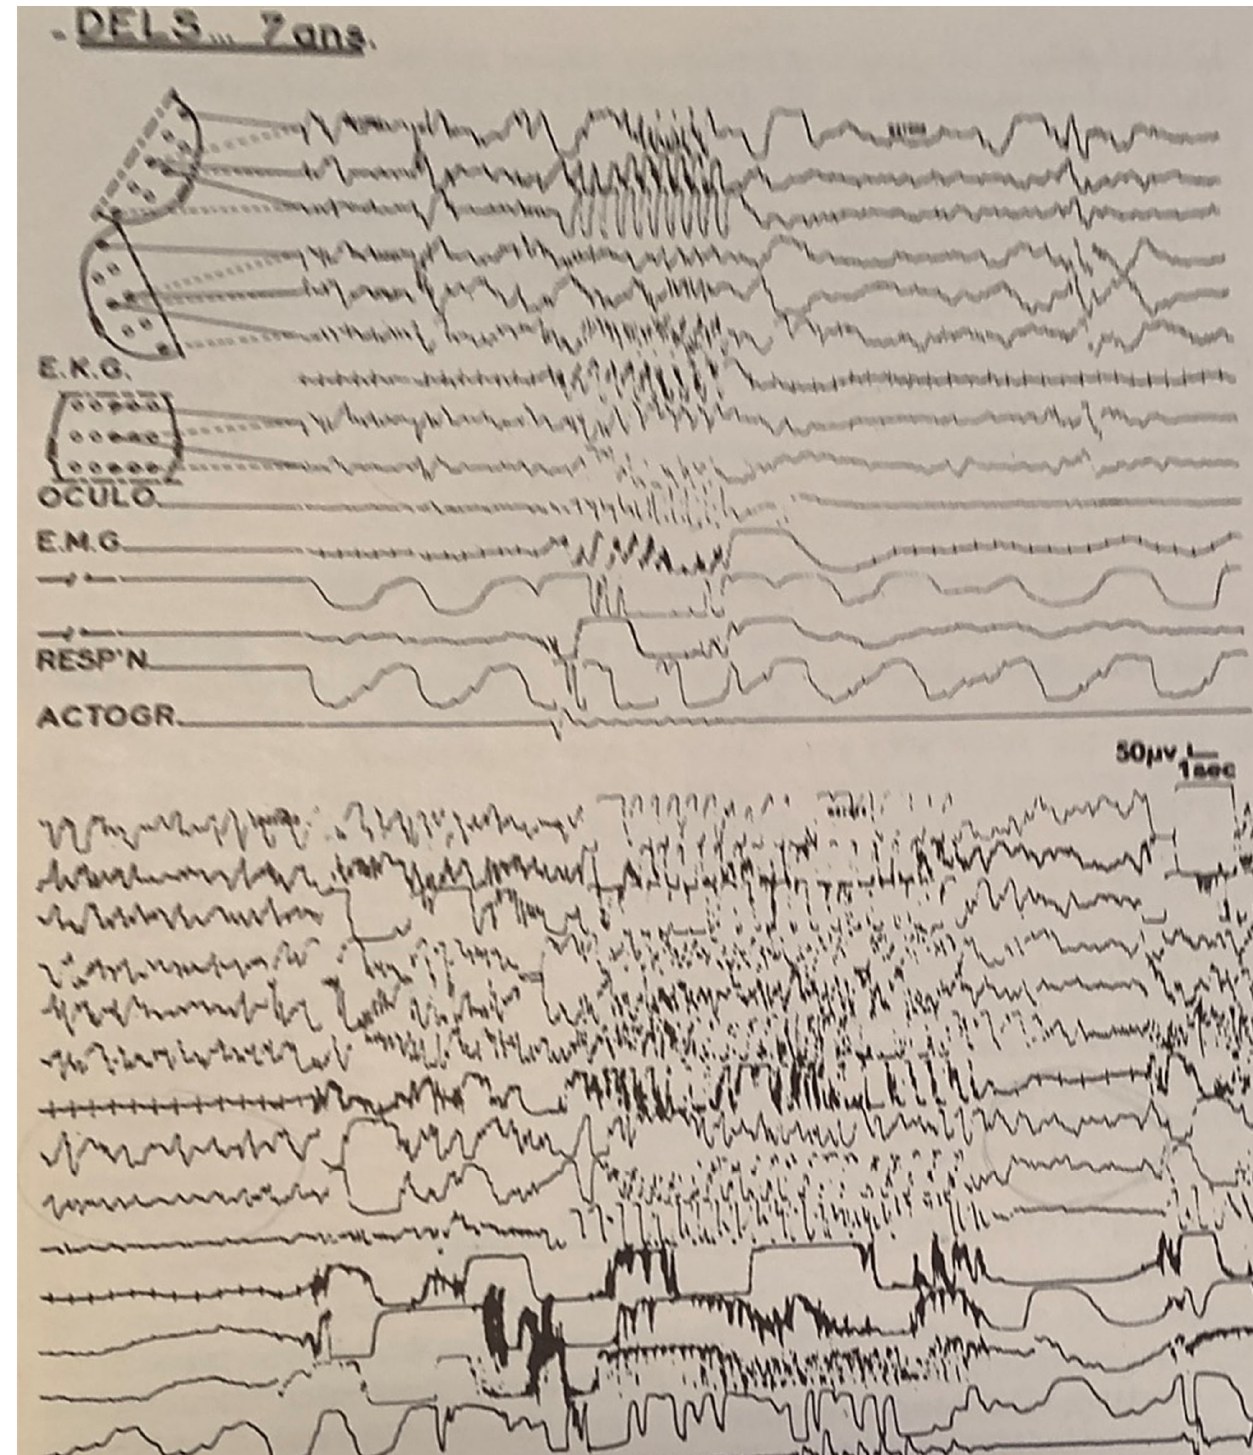
Figure 22. Extreme jactatio capitis nocturna in a 7 ‐ year old child with total body movements. Such body rocking recurs at about 2–3/second and is recorded in all EEG channels and as artifacts on